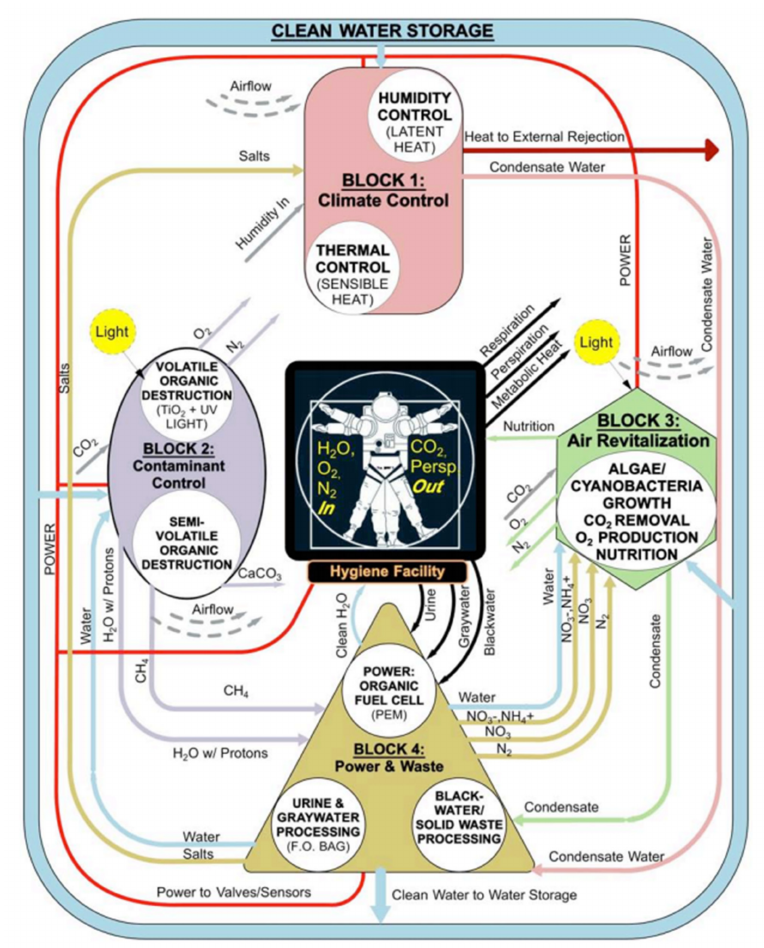
Figure 5. Initial concept of water wall system architecture. Credit to Cohen et al., 2014. Permission granted by the copyright holder (Marc M.